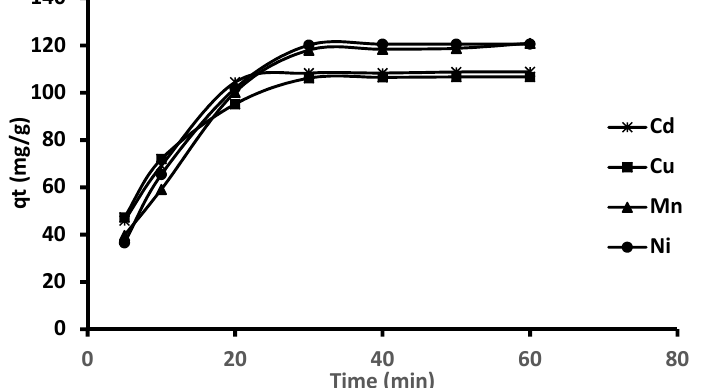
Figure 7. Effect of contact time on the adsorption of Cd, Cu, Mn and Ni by Fe 3 O 4 -ZrO 2 @APS nanoadsorbent.